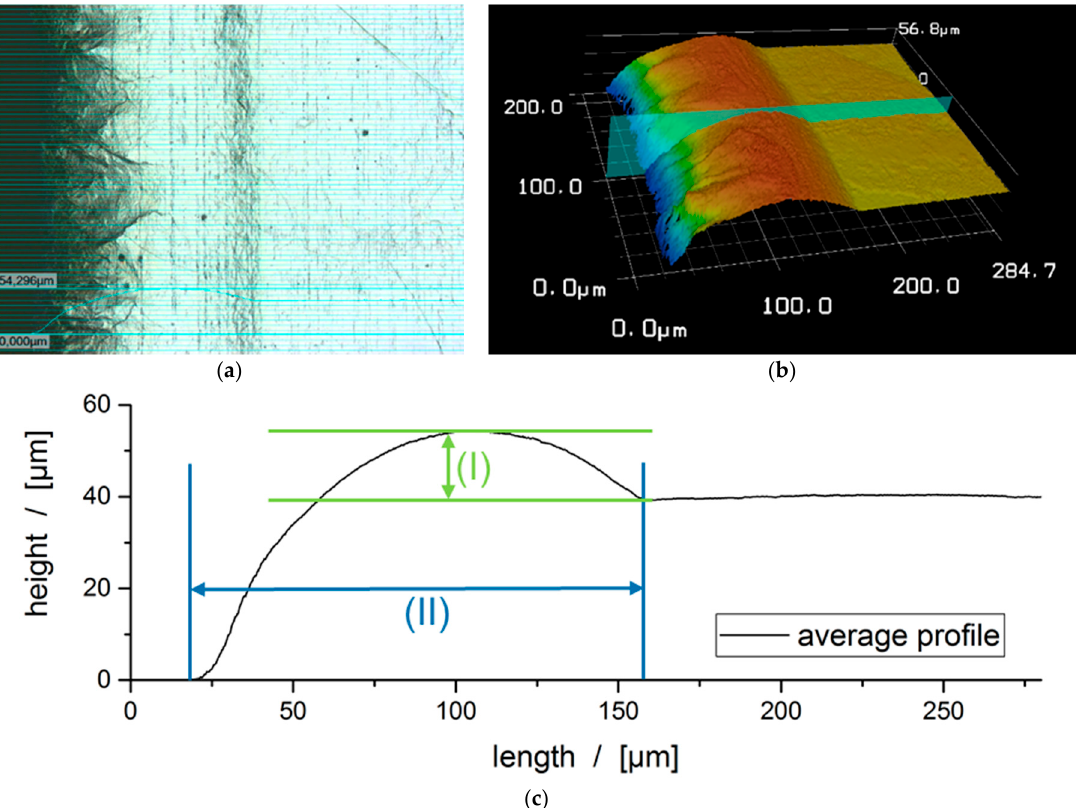
Figure 4. Analysis of a laser cut lithium sheet of 50 µm thickness: ( a ) Light microscope section; ( b ) Laser scanning microscope sections; ( c ) Schematic representation, (I) Melt formation width, (II) Melt superelevation; Laser plant parameters: 350 kHz; 240 ns; 150 mm/s.